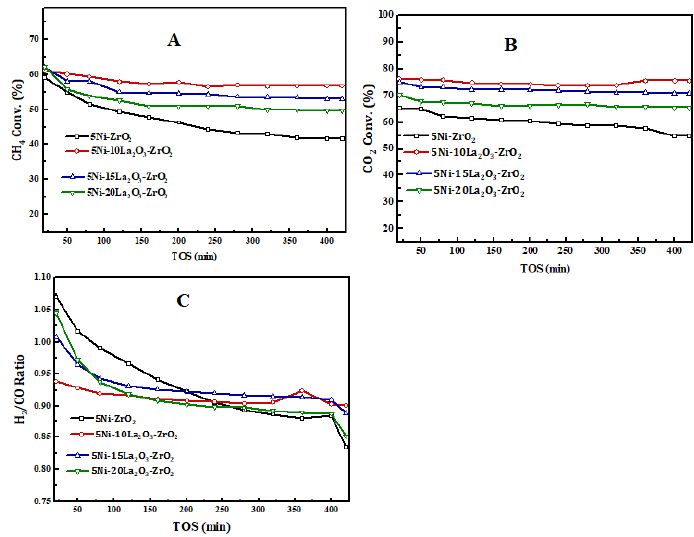
Figure 5. Conversion of ( A ) CH 4 and ( B ) CO 2 at 700 °C, one atmosphere, and GHSV = 42 l/h/g cat . of 5Ni-ZrO 2 and La 2 O 3 -promoted 5Ni-ZrO 2 catalyst; ( C ) H 2 /CO